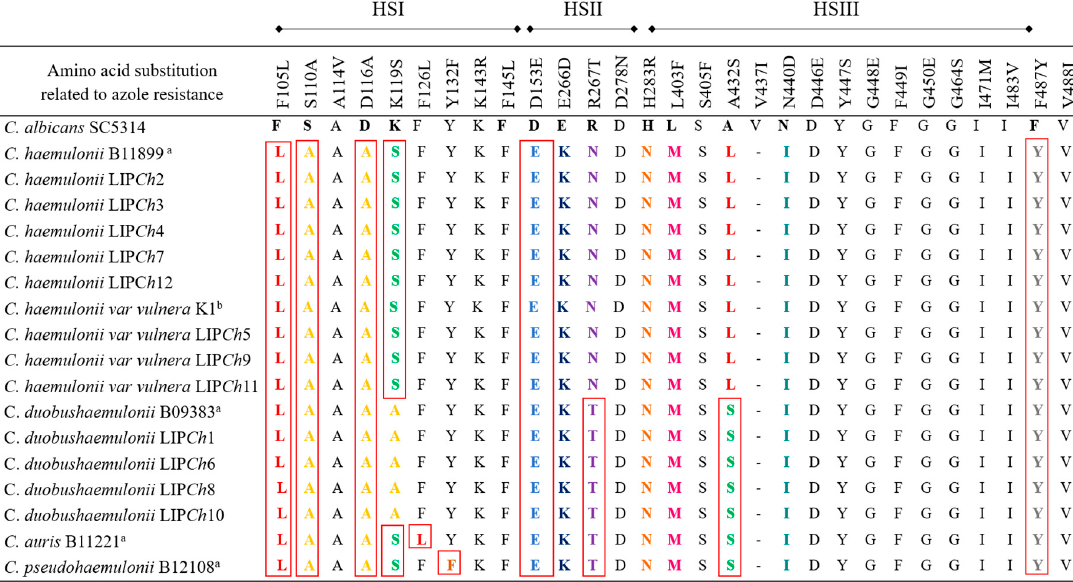
Figure 5. Multiple alignment of the azole drug target ERG11p. Observed amino acid substitutions in C. albicans compared with the clinical isolates of the C. haemulonii species complex. Red boxes indicate the observed azole resistance amino acids substitutions in the three different hotspots (HSI, HSII, and HSIII). Amino acid numbers are based on the C. albicans protein sequence. Previously published by a Muñoz et al. [23] and b Rodrigues et al. [13]. Colored letters are mutations encountered in the sequence alignment. Red boxes are mutation previously described in resistant strains of C. albicans .